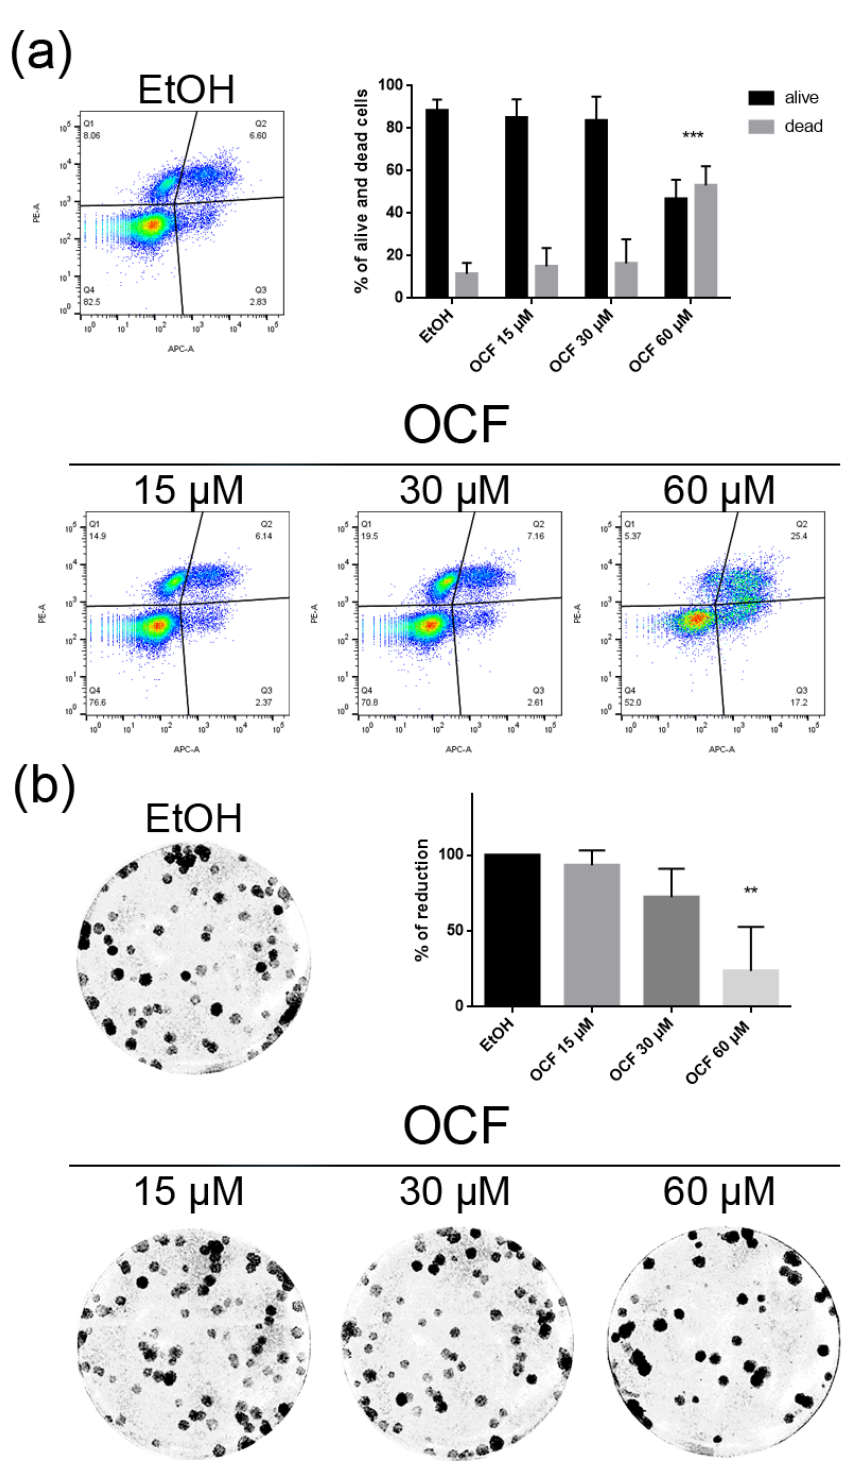
Figure 7. Vitality and the colony formation assay of the OCF-treated TAXr cells. TAXr cells were treated for 72 h with vehicle or with different doses of the OCF; plots and corresponding histograms for live/dead cells percentages obtained using an annexin V/PI double staining are shown ( a ). Cell colonies obtained after 72 h of the vehicle/OCF treatment and the corresponding percentage quantification ( b ). Data are presented as mean ± SD of three independent experiments. Results of the representative experiments are shown. ** p < 0.01, *** p < 0.001. ( a ) Two-way ANOVA Tukey’s multiple comparisons test; ( b ) One-way ANOVA Dunnett’s multiple comparisons